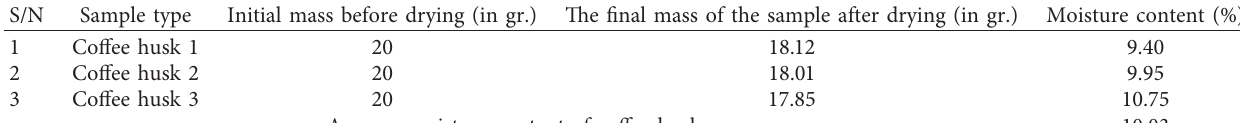
Table 2: Moisture content of coffee husk [9].